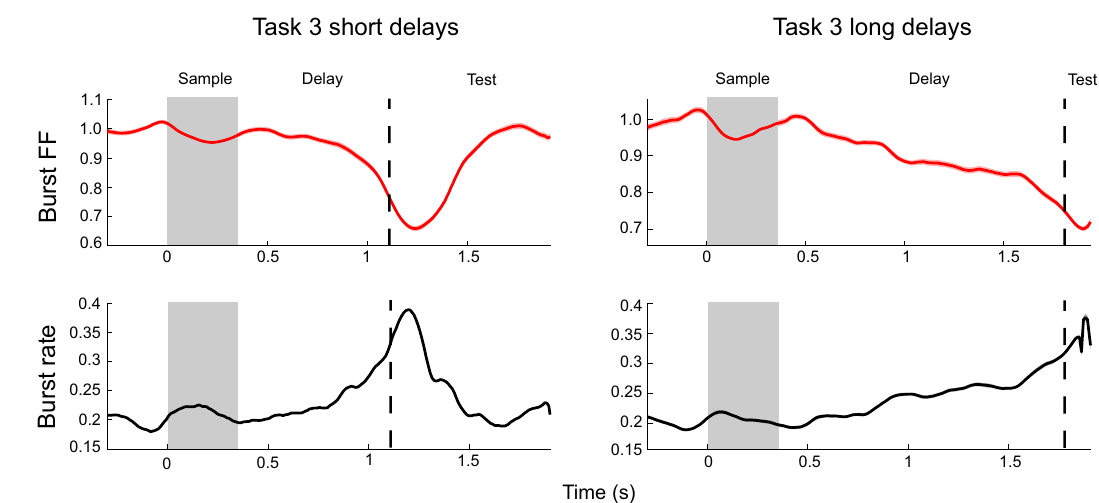
Figure 4. Burst variability in Task 3. Top row shows the gamma burst FF for short (left) and long (right) trials. Bottom row plots the corresponding gamma burst rates. Shaded areas indicate standard error of